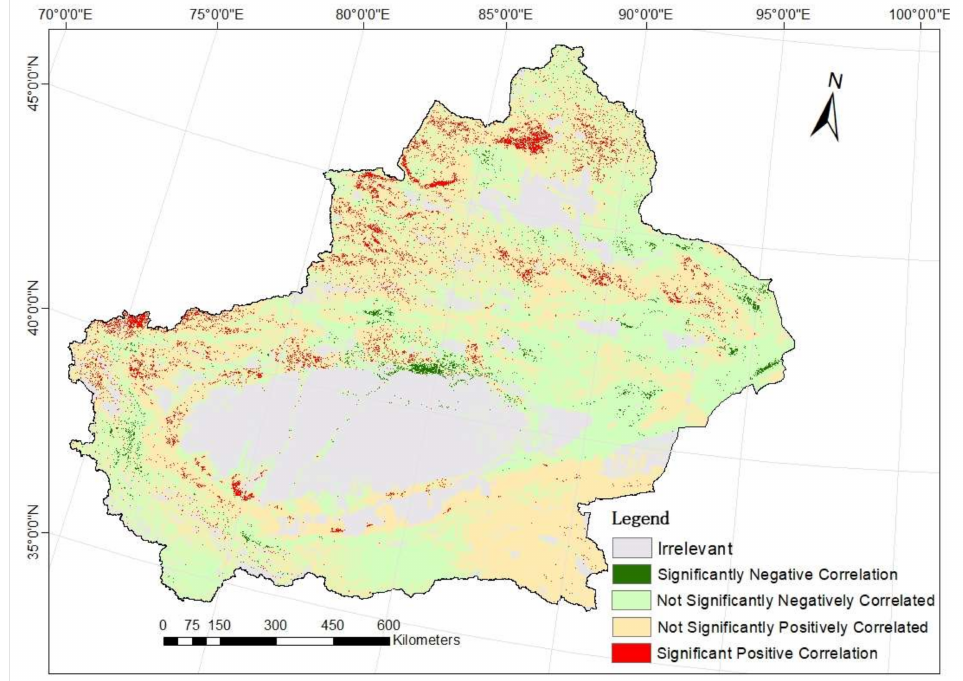
Figure 6. Partial correlations between annual mean precipitation and